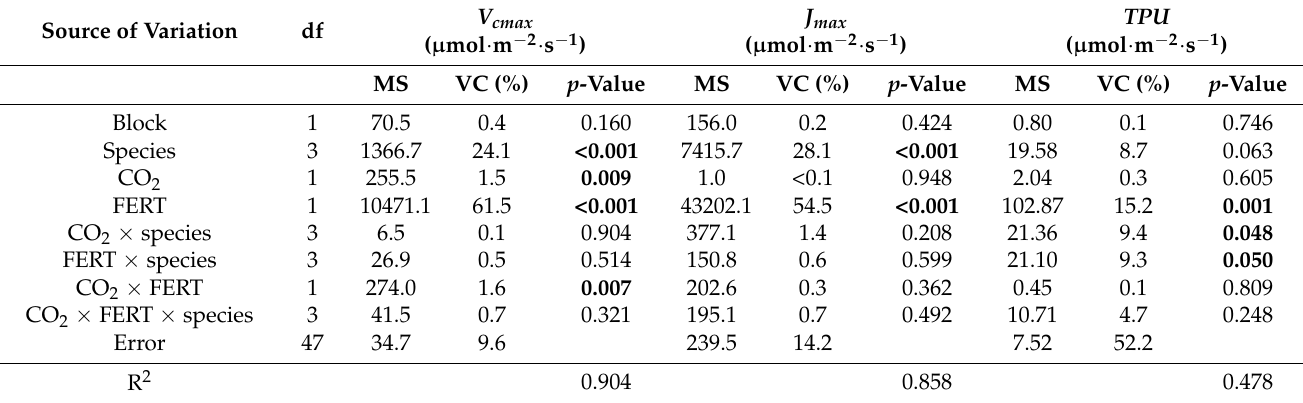
Table 6. Assimilation to internal CO 2 traits and ANOVAs from the CO 2 × fertilizer treatment experiment, 2018, including source of variation, degrees of freedom (df), mean square values (MS), variance components (VC), p -values, and coefficient of determination ( R 2 ). p -values < 0.05 are in bold